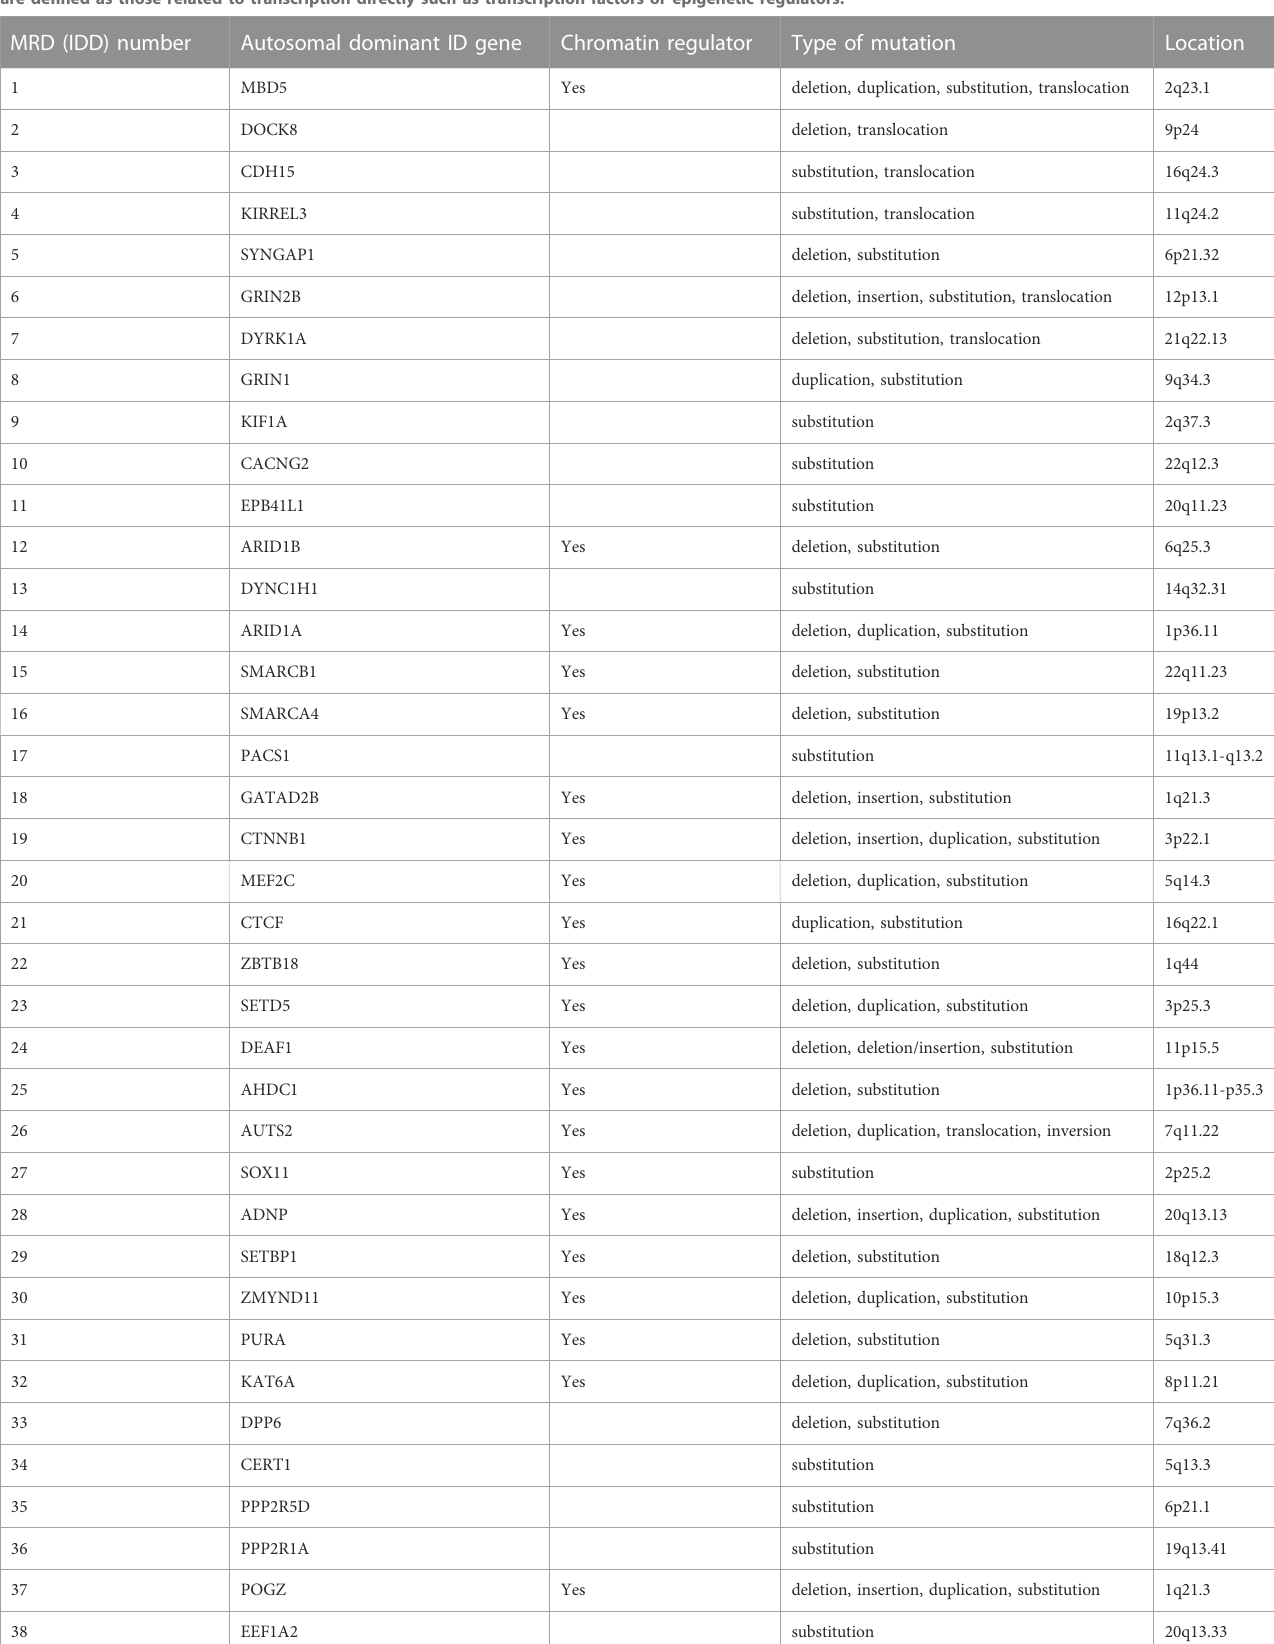
TABLE1GenesassociatedwithMRDintheOMIMdatabase.Giventhattheterm “ mentalretardation(MR) ” isbeingreplacedintheliteraturewith “ intellectualdisability (ID), ” we propose that “ MRD ( “ mental retardation, ” autosomal dominant) ” be replaced with “ IDD (intellectual disability, autosomal dominant). ” Chromatin regulators are de fi ned as those related to transcription directly such as transcription factors or epigenetic